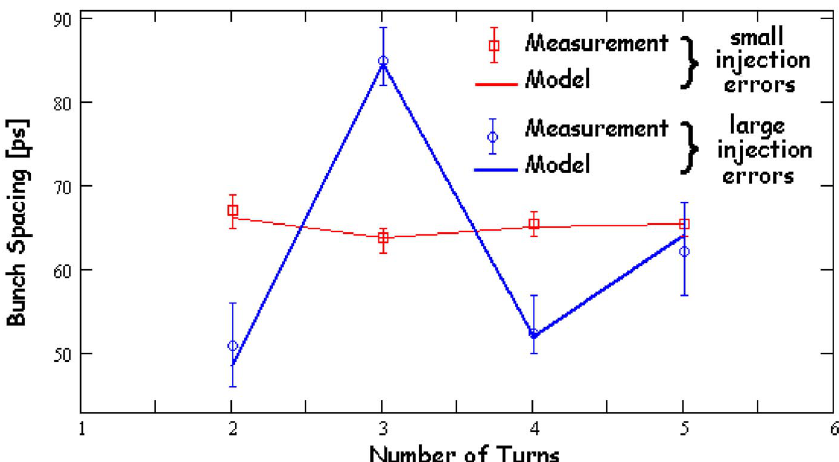
FIG. 27. (Color) Bunch spacing variations after the combination of two pulses as a function of the number of turns for large (circles) and small (squares) injection errors. The solid curves correspond to the model predictions in both cases.